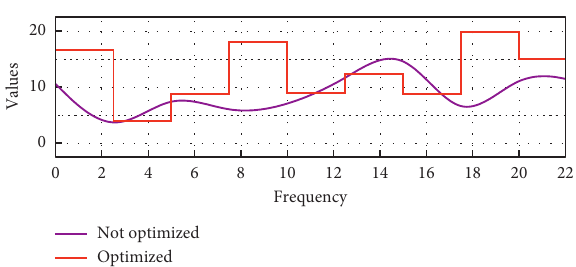
Figure 9: Pitch sequence DTW matching